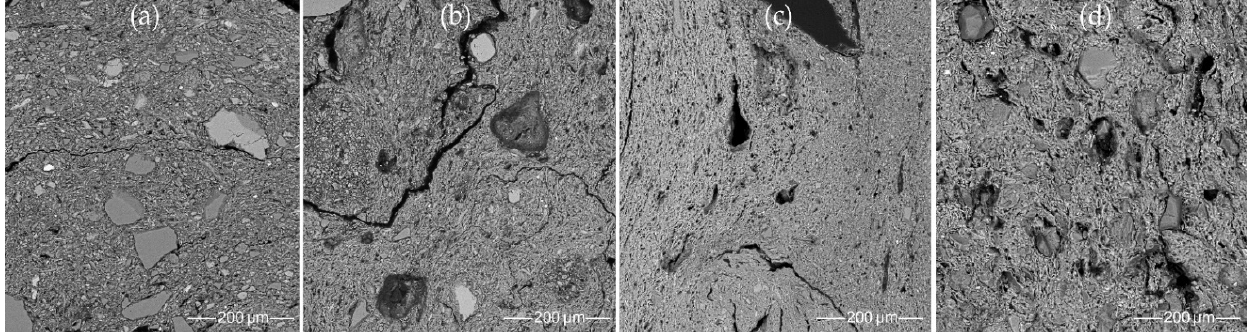
Figure 15. SEM BSE images of the clay matrix: ( a , b ) micaceous poorly weathered clay: ( a ) HG-E_M5, ( b ) CW-E_M2; ( c , d ) mature, well-weathered illite clay: ( c ) HG-L_B3, ( d ) CW-L_M4.